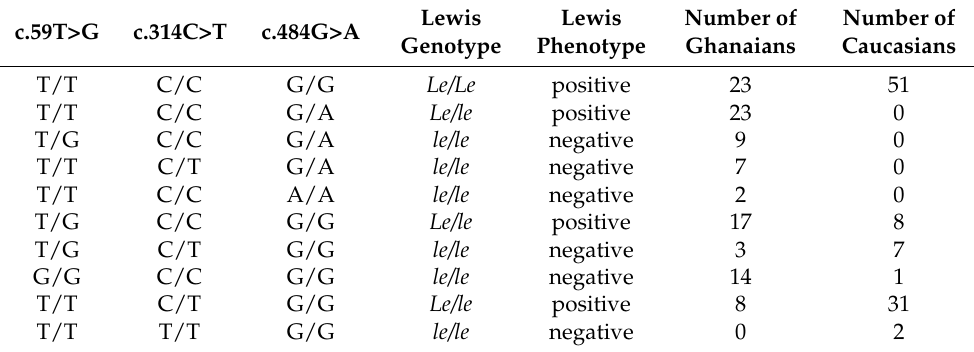
Table 3. Inferred Lewis genotypes and phenotypes from three